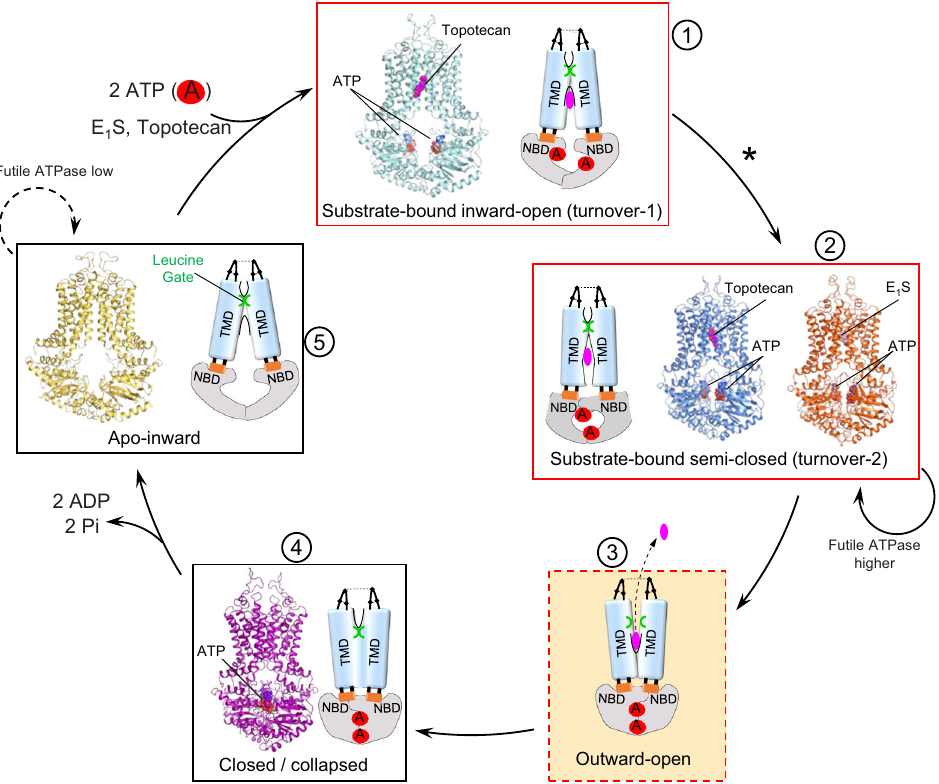
Fig. 6 Transport mechanism of ABCG2. Schematic of structure-based, proposed transport cycle of ABCG2. Key states are shown as boxes and numbered. Where available, structures are shown as ribbon diagrams with bound nucleotides and substrates shown as spheres and labeled. Cartoon schematics of the relevant states are drawn to emphasize the conformations of the TMDs and NBDs, identify cavities, indicate the presence of bound drugs, and as well as the state of the leucine gate. Previously determined structures correspond to PDB IDs 5NJ3 (apo-inward) and 6HBU (closed conformation). No structure is available of the proposed outward-open conformation (state Our mechanistic scheme indicates two distinct levels of ATPase have a dual role in the turnover-2 state: It pioneers the contact activity, a basal and a stimulated level (Fig. 6). In the absence of between the two NBDs while simultaneously strengthening the binding of ATP through a cation- π interaction with the adenine 0.65 molecules of phosphate per ABCG2 dimer per second. In the moiety. The initial NBD-NBD contact is probably important presence of E 1 S, the ATPase rate increases to 2.4. We compared because the signature motif is not yet close enough to interact with the ribose and triphosphate moieties of the ATP molecule. this value with the initial E 1 S transport rate, which is 0.1